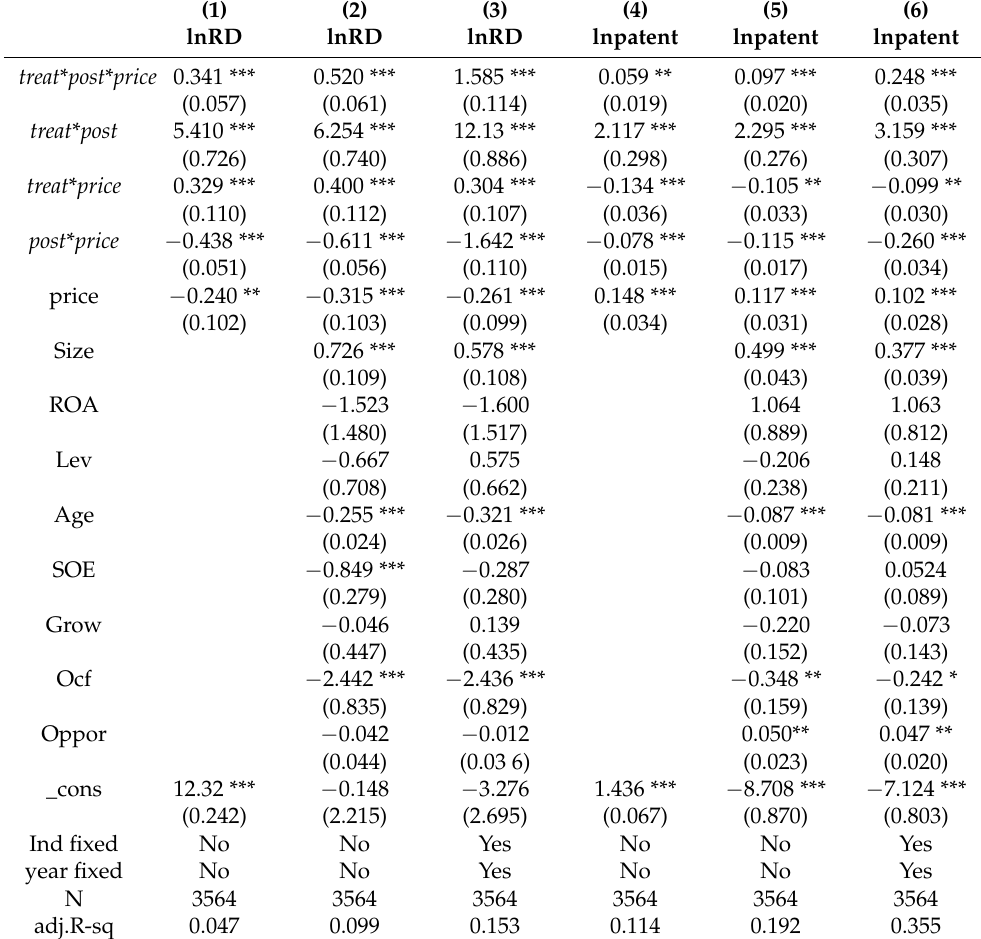
Table 4. The moderating effect of annual average carbon price in in the carbon